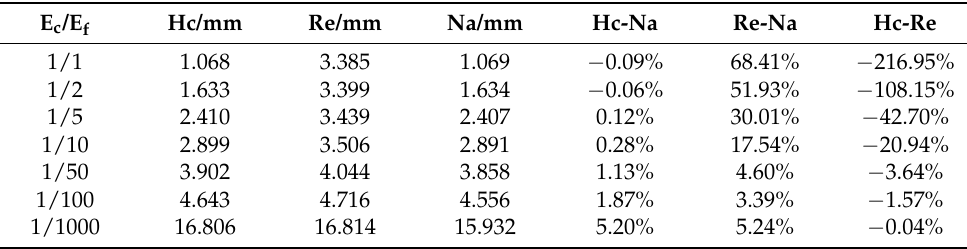
Table 1. Maximum deflection of the circular sandwich plate simply supported at its periphery with different modulus of elasticity of the core